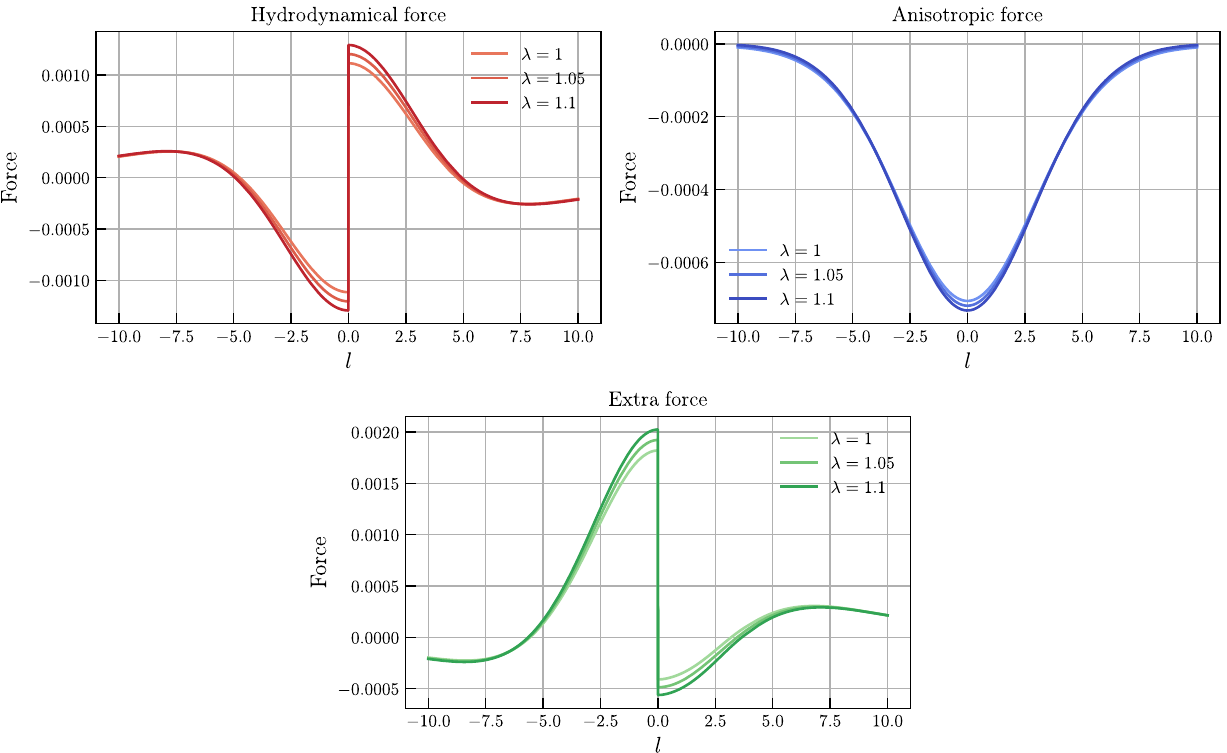
Fig. 5 Forces that are present in the modified TOV equation for the Hu–Sawicki f ( R ) gravity. As usual, we assume that b 0 = 5 and (cid:17) = 1, m = 2, α = 0 . 5 and β = 0 . 1, R c =